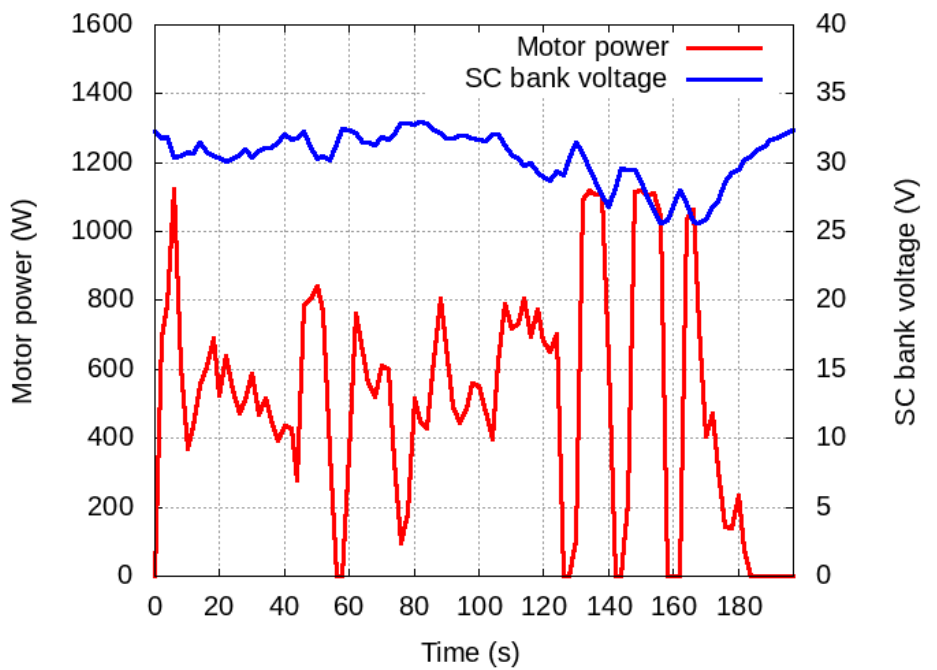
Figure 10. Power and SC voltage diagram, created from data logged during the 2nd lap of the Shell Eco-marathon Europe